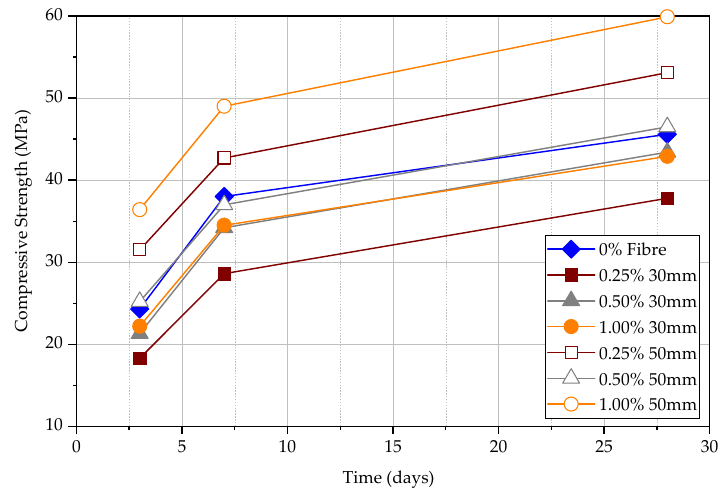
Figure 8. Compressive strength for different fibre content at 3, 7, and 28 days.